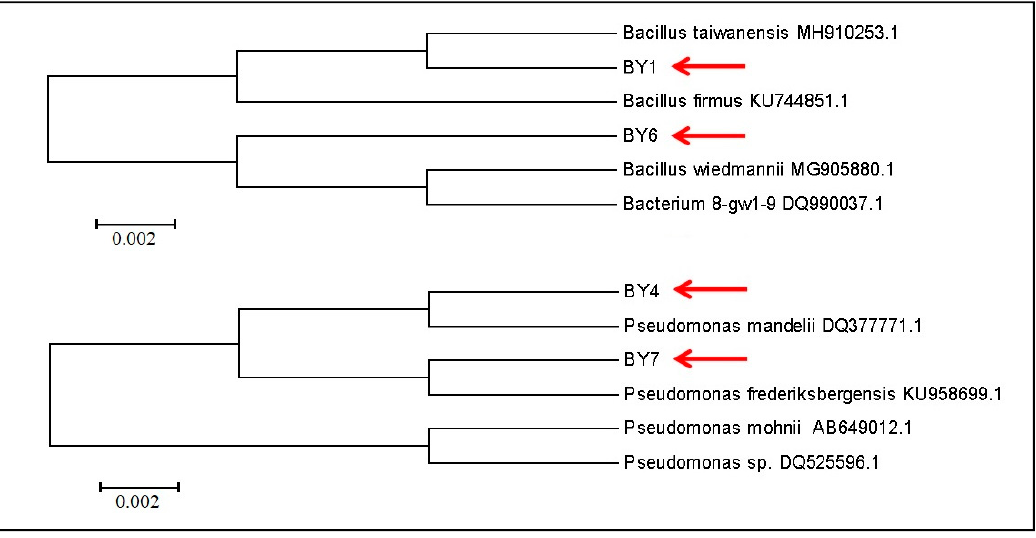
Figure 2. Phylogenic tree of the 16S rDNA gene sequence of BY1, BY4, BY6, and BY7 derived by MEGA 4.0 software.